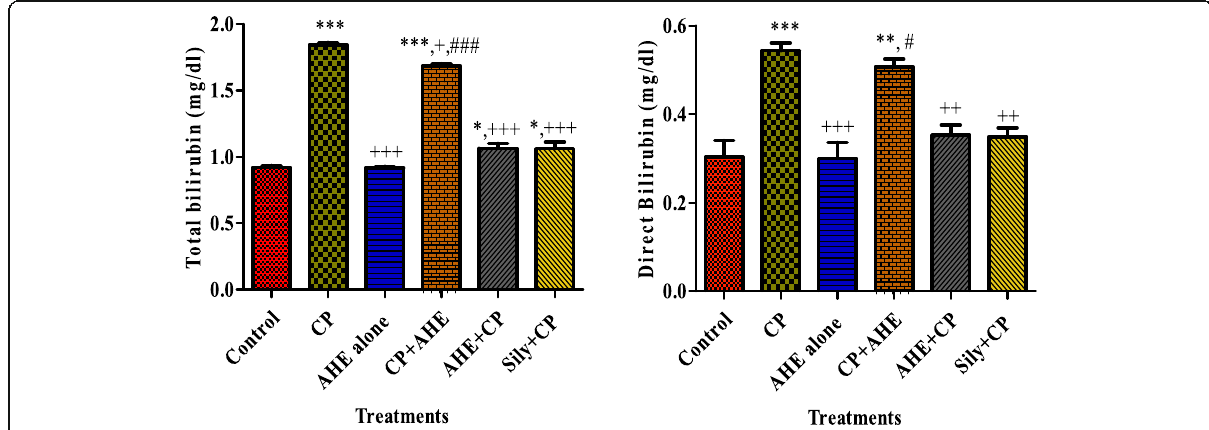
Fig. 2 Effect of cisplatin (CP) and different treatments of AHE on serum total bilirubin and direct bilirubin profile, Values expressed as mean ± SEM. *, **, *** shows significance from control group at p < 0.05, p < 0.001, p < 0.0001, ++, +++ shows significance from Cisplatin (CP) group at p < 0.001, p < 0.0001. #, ### shows significance from AHE + CP pre-treated group vs. CP + AHE post-treated group respectively. Non-significant difference ( p > 0.05) was recorded between control and AHE alone treated group in all parameters (One way ANOVA followed by Tukey ’ s multiple comparison tests)